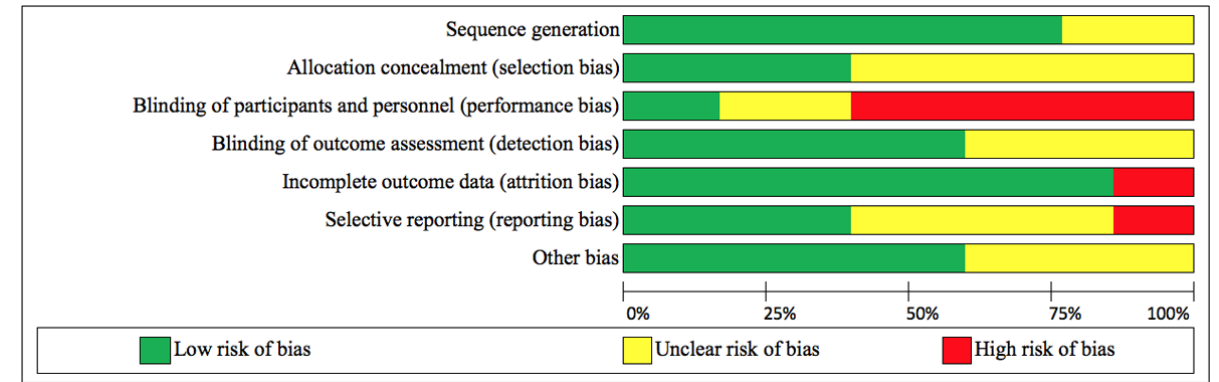
Figure 2. Risk of bias. Judgments about each risk of bias item presented as percentages across all included